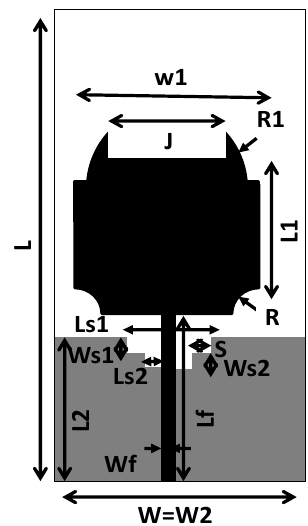
FIGURE. 1 The adopted single patch antenna